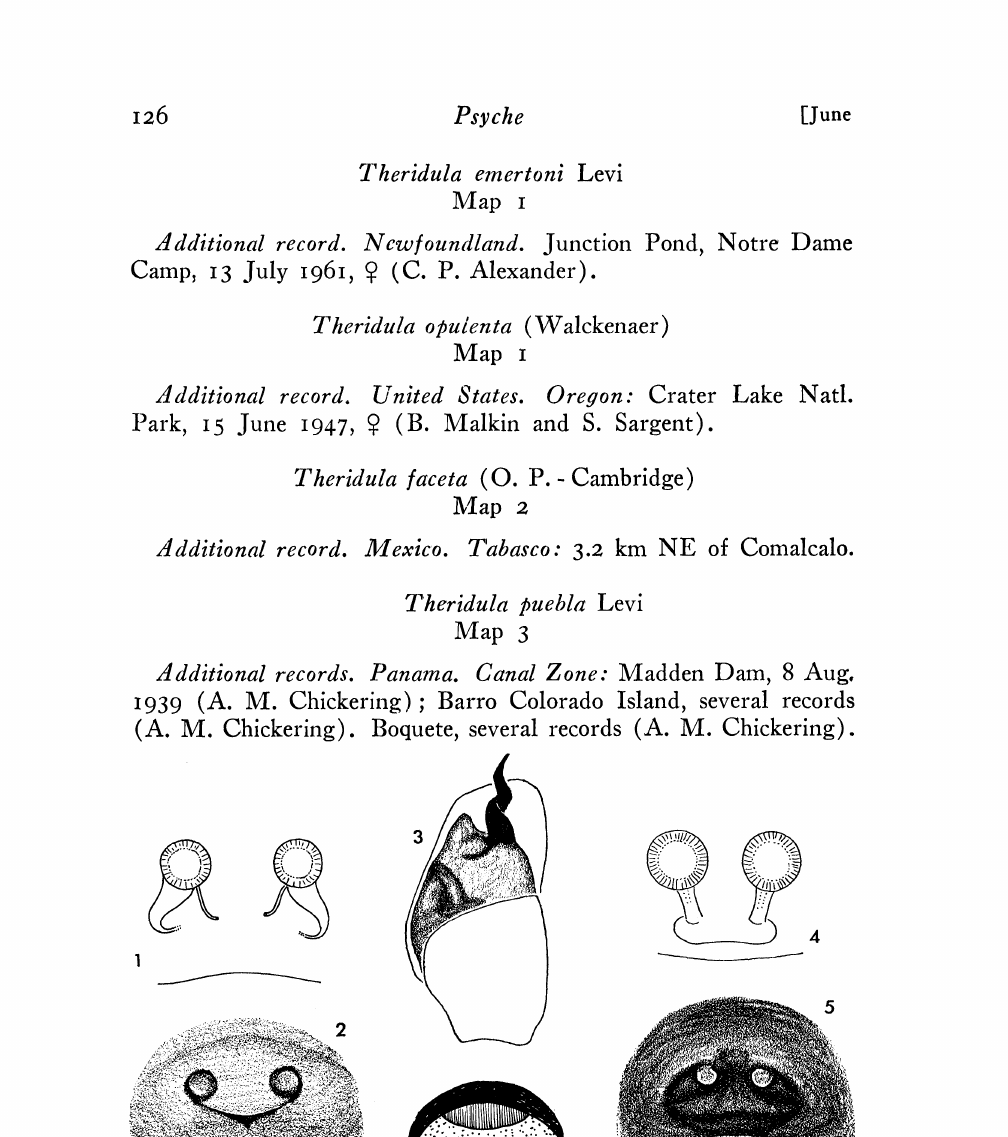
Figs. 1, 2. Theridula multiguttata Keyserling. 1. Female genitalia, dor- sal view. 2. Epigynum. Figs. 3-5. T. nirerrima (Petrunkevitch). 3. Left palpus. 4. Female geni- talia, dorsal view. 5. Epigynum. Fig. 6. T. olita Mello-.Leitao, epigynum after